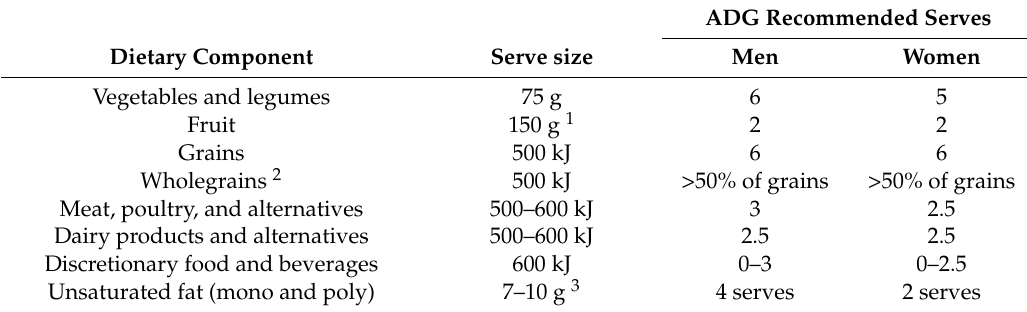
Table 1. Serve sizes of foods and nutrients and recommended serves from the Australian Dietary